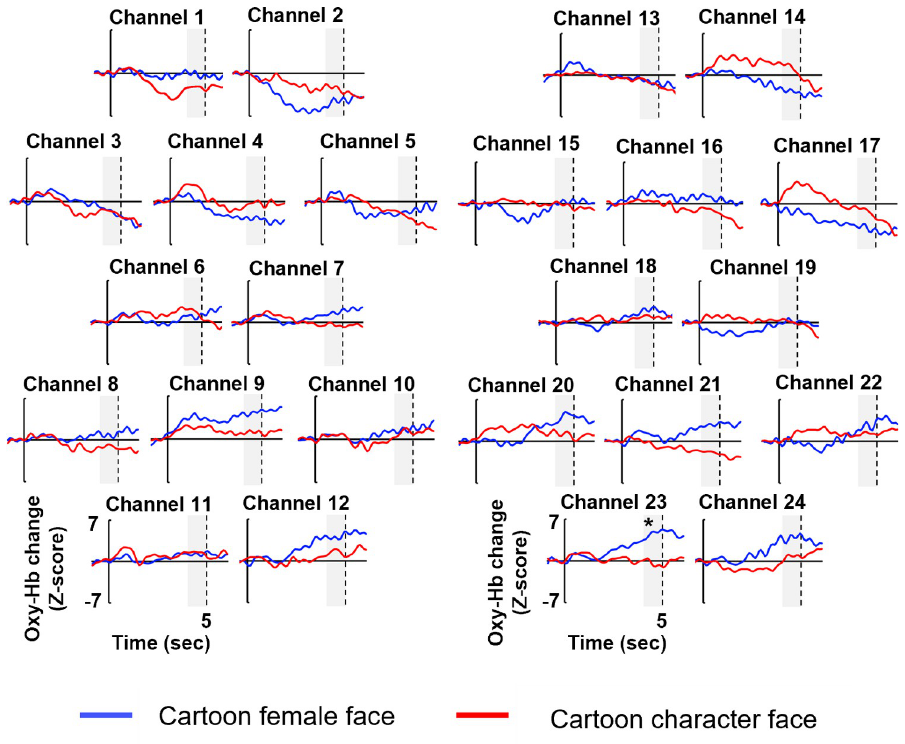
Fig 5. The time course of average oxy-Hb concentration during the cartoon female and cartoon character face conditions in each of the 24 channels. The blue line in the graph represents the mean Z score in the cartoon female face condition, and the red line represents that in the cartoon character face condition. On the horizontal axis, 0 represents the beginning of the test period and 5 represents the end of the test period. The shaded area represents the zone for the statical analysis, the last 1 s of the test period. In 23 channel, the concentration of oxy-Hb in cartoon female face condition were significantly greater than chance level of 0 and that in cartoon character face condition. � p <